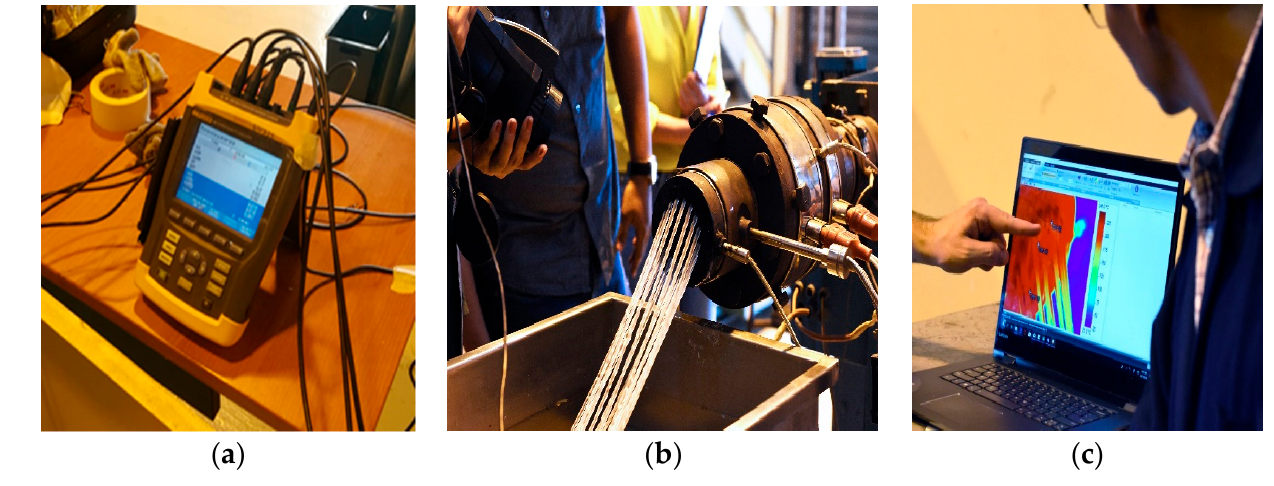
Figure 3. An energy analyzer ( a ) and thermal imager ( b , c ).